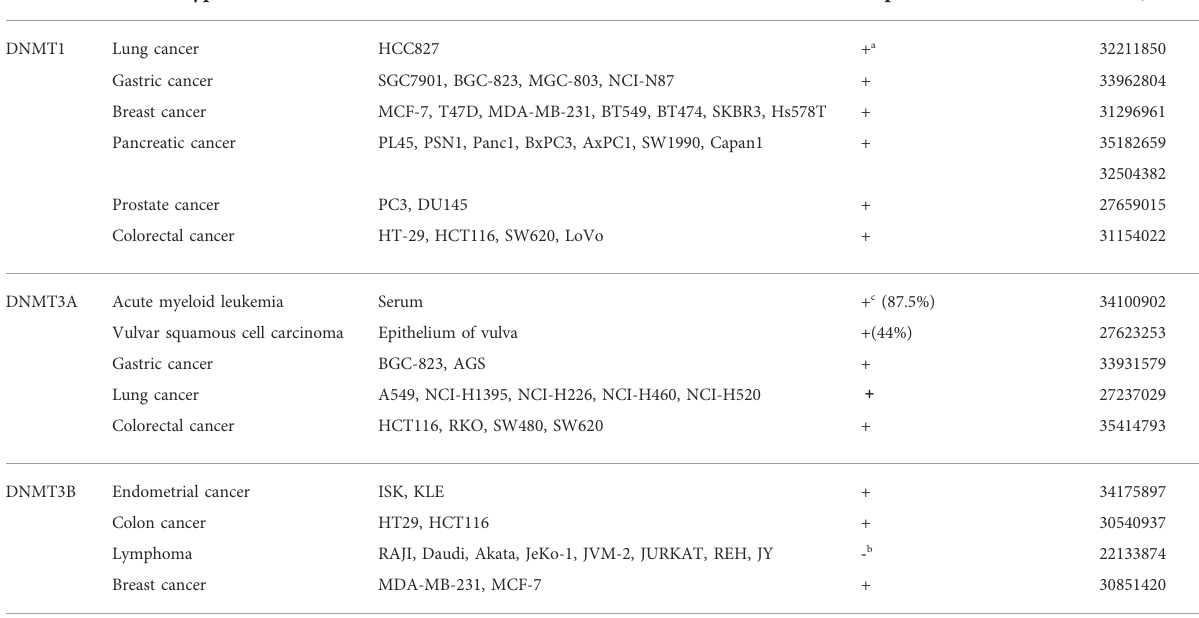
TABLE 1 DNMTs and their expression in various